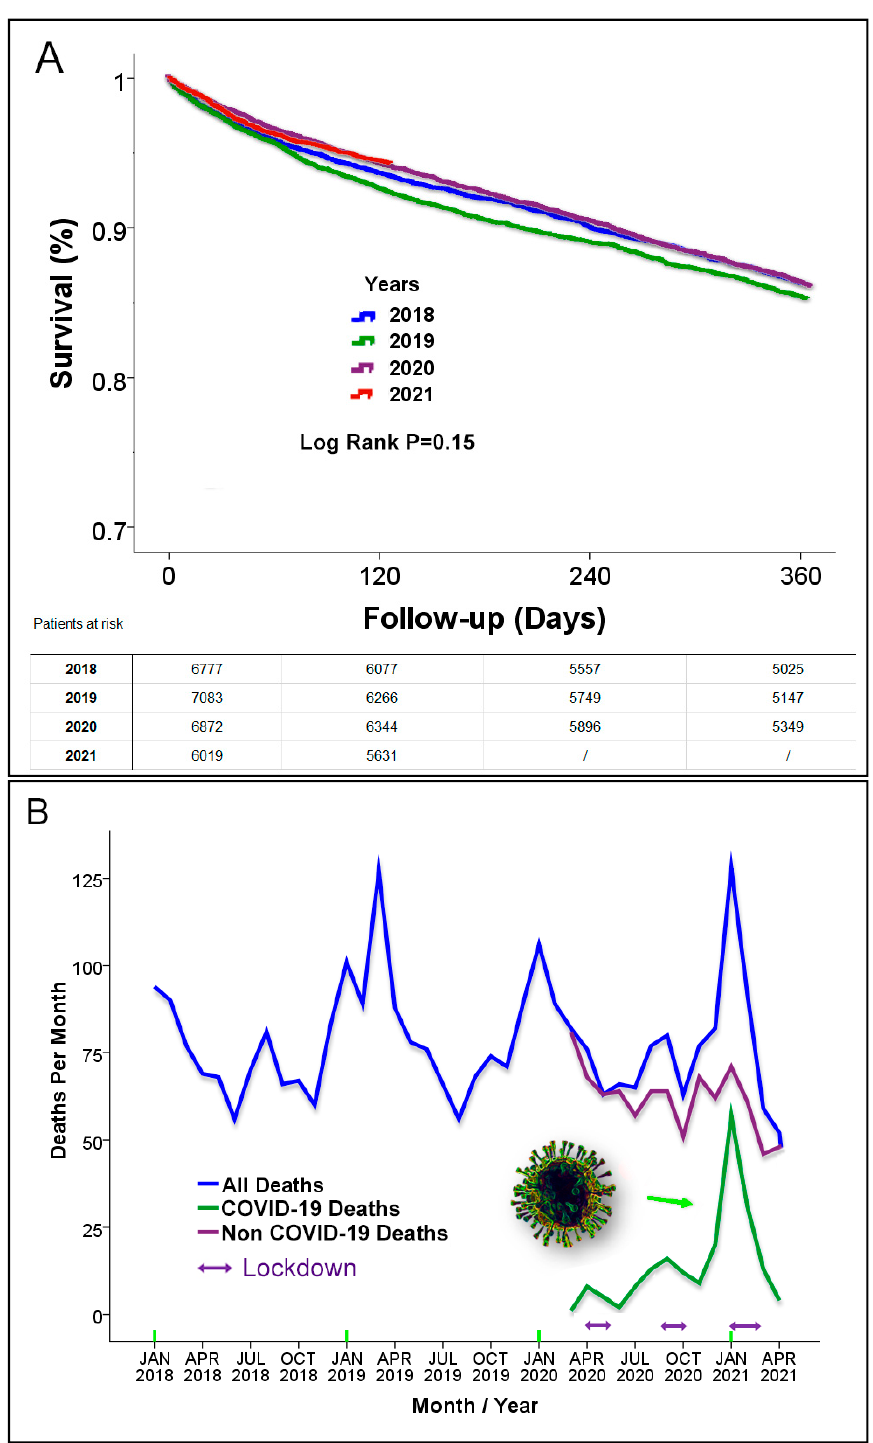
Figure 3. Survival data and death causes during and prior to the pandemic. ( A ) Kaplan–Meier survival curves for HF patients per year. Survival rates prior to the pandemic (2018–2019) and during the pandemic (2020). Survival rates were very similar: 86.2 ± 0.4% vs. 85.3 ± 0.4% vs. 86.0 ± 0.4%, respectively, p = 0.15. Survival data during the first quarter of 2021 are also depicted with a survival curve that was very similar to previous years but not included in the log-rank analysis. ( B ) Death rates per month prior to and during the pandemic. Deaths are divided by death due to COVID-19 and to other causes. A decline of the HF mortality deaths from other causes replaced with deaths due to COVID-19.